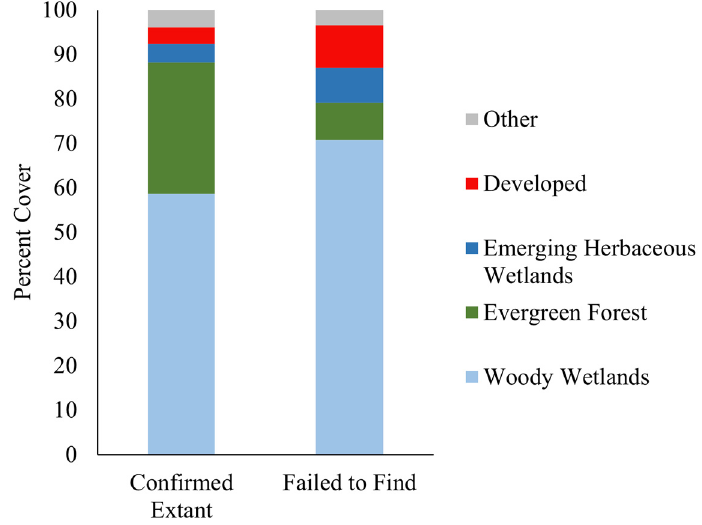
Figure 3. Percent cover of dominant land cover categories within 500 m of S. floridana populations that were confirmed to be extant and populations in which we were unable to locate any individuals during 2021 field surveys. See Table S1 for more information. Table 1. Locations, number of sites, and samples collected; expected ( H E ) and observed ( H O ) het- erozygosity; inbreeding coefficient ( F IS ); relative evidence of population divergence (based on F ST and DAPC); evidence of unique ancestry; and relative genetic value of twelve populations of S. floridana . Samples from LB were collected by Ms. Amy Jenkins (FNAI) and mailed to Miami University, OH, in April 2020. Genetic value determined as described in Materials and